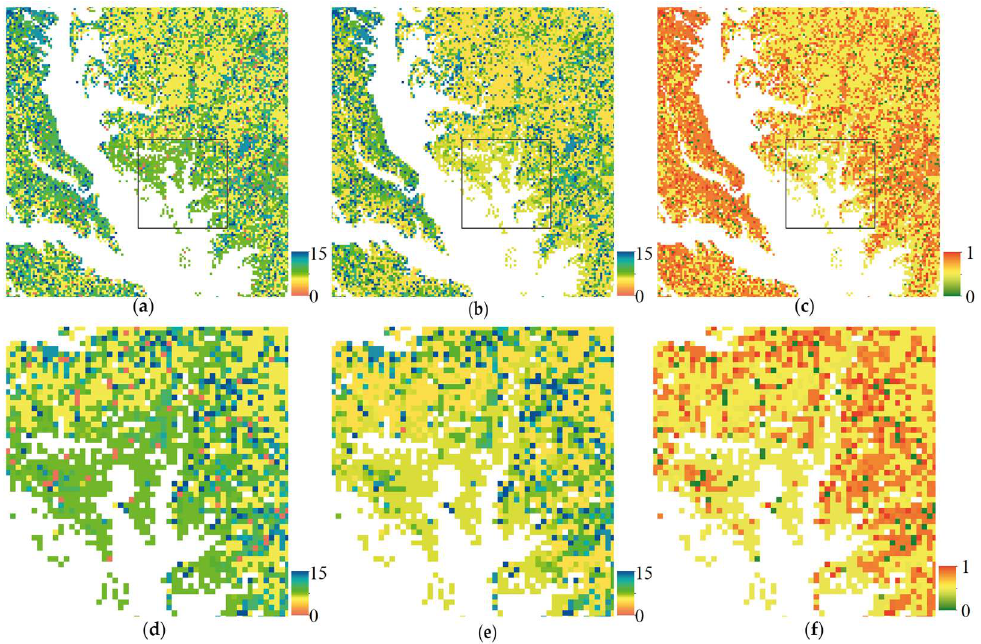
Figure 6. Comparison of ratio of total ecosystem carbon storage (TEC) in different scenarios. (a) Ratio of TEC in scenario LULCC of 2011 and initial TEC of 2001; (b) ratio of TEC in scenario without LULCC of 2011 and initial TEC of 2001; (c) ratio of TEC in scenario LULCC of 2011 and TEC in scenario of LULCC in 2011; (d), (e) and (f) are zoomed-in figures of interest areas in black squares, respectively, of (a), (b), and (c).